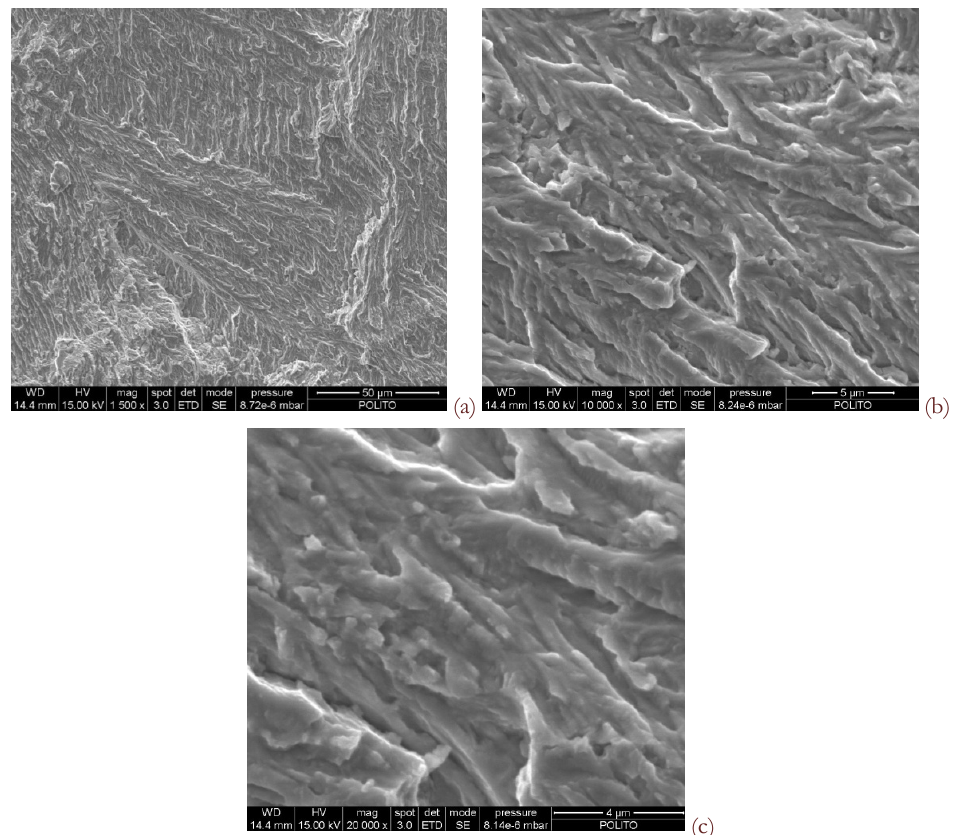
Figura 13: Superficie di frattura per fatica di una martensite rinvenuta, situata a circa 28 mm dalla superficie di una barra di 90 mm di diametro, fabbricata con acciaio EN 34CrMo4 legato con B, temprato e rinvenuto. Ingrandimenti crescenti (a,b,c). Figure 13: Fatigue fracture surface of a tempered martensite zone, located at 28 mm ca. from the surface of a 90 mm dia. bar, made with a quenched and tempered EN 34CrMo4, B alloyed steel; increasing magnifications